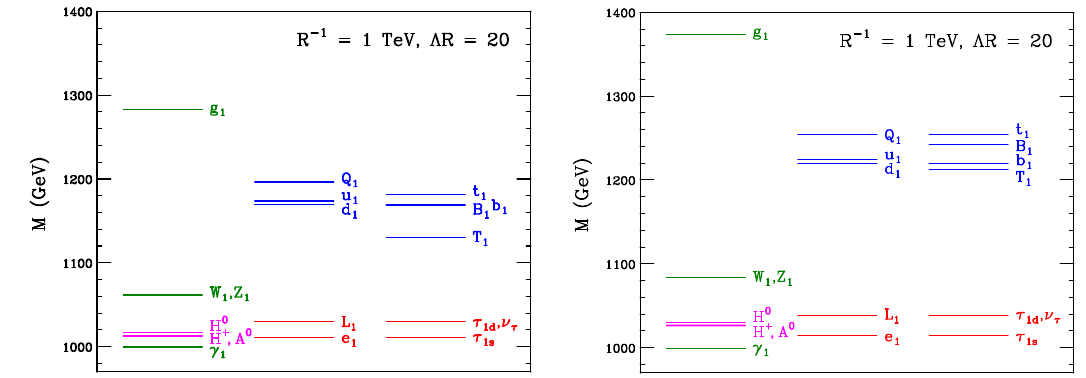
Figure 8 . Mass spectrum of KK particles at level-1 for R (cid:0) 1 = 1 TeV and (cid:3) R = 20 without (left) / with (right) (cid:12)nite